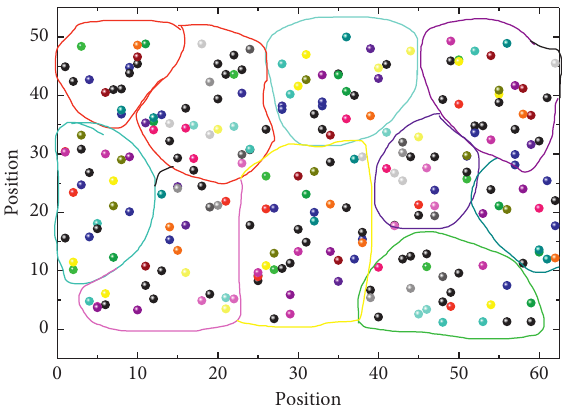
Figure 7: Four types of data classification.